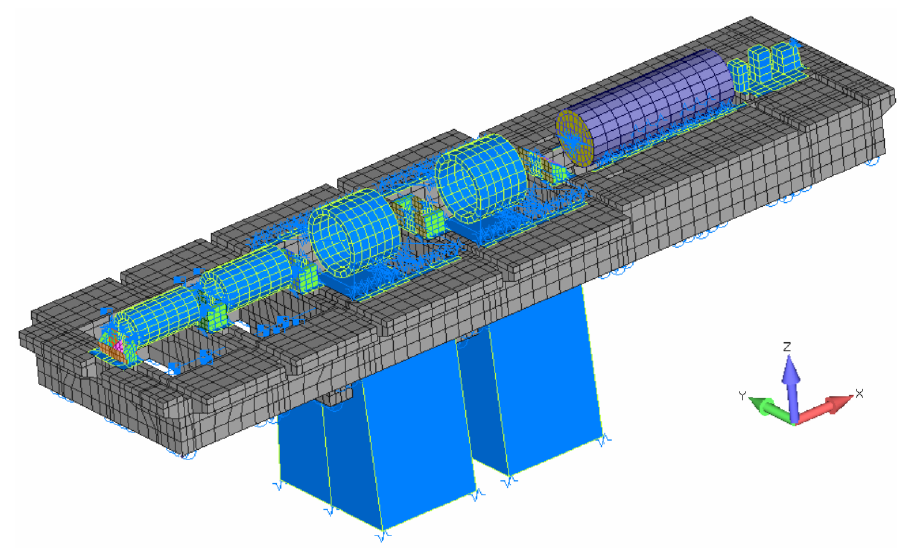
Figure 5. Visualization of a foundation and stator parts.